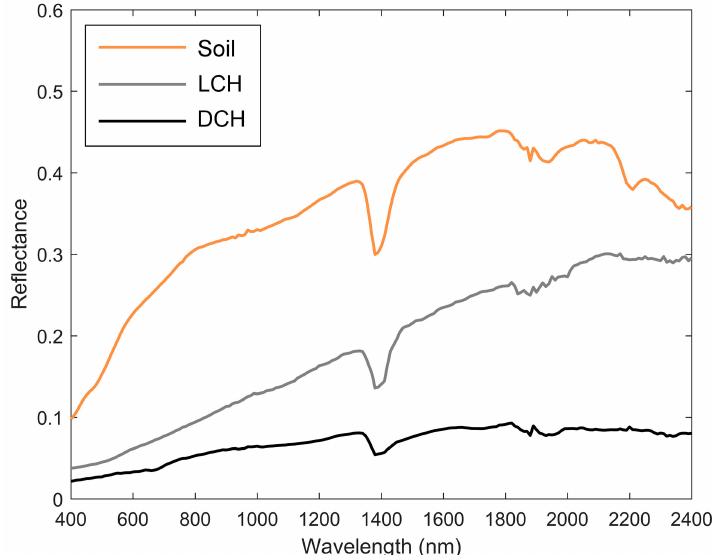
Figure 4. The reference spectrum used as post-fire background layer: soil (brown curve), dark charcoal (DCH; black curve), and light charcoal (LCH; a mixture of charcoal and ash, grey curve). The reference spectrum was provided by De